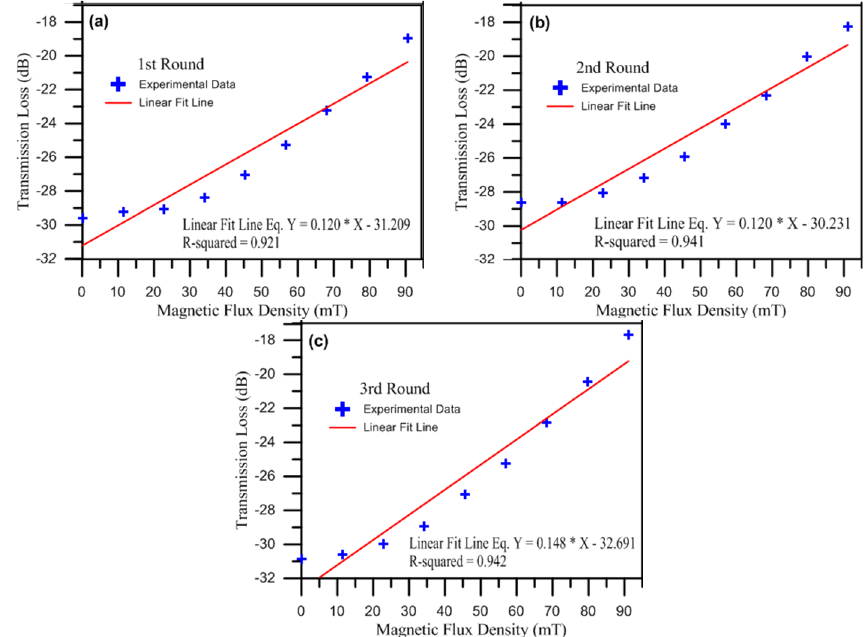
Figure 6. The resonant dips of the transmission loss for the MRSLPFG magnetic sensor under various magnetic flux densities. ( a ) The relationship for the first round of magnetic field sensing. ( b ) The relationship for the second round of magnetic field sensing. ( c ) The relationship for the third round of magnetic field sensing.